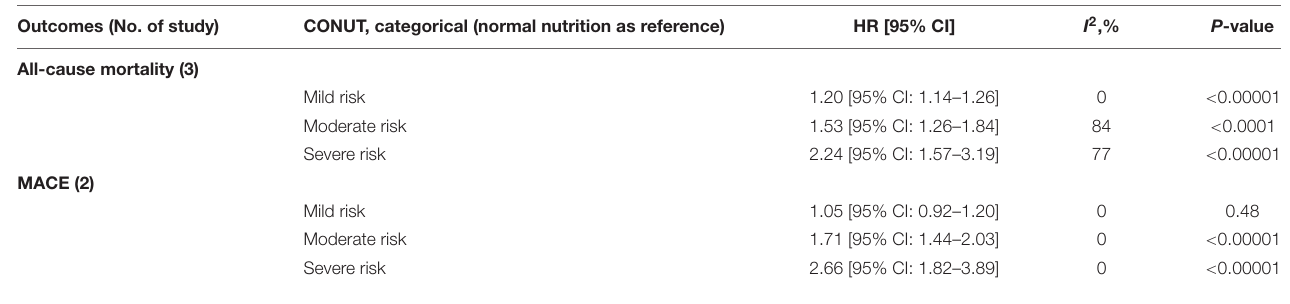
TABLE 2 | Meta-analysis on all-cause mortality and MACE by categorical analysis of CONUT score. Outcomes (No. of study) CONUT, categorical (normal nutrition as